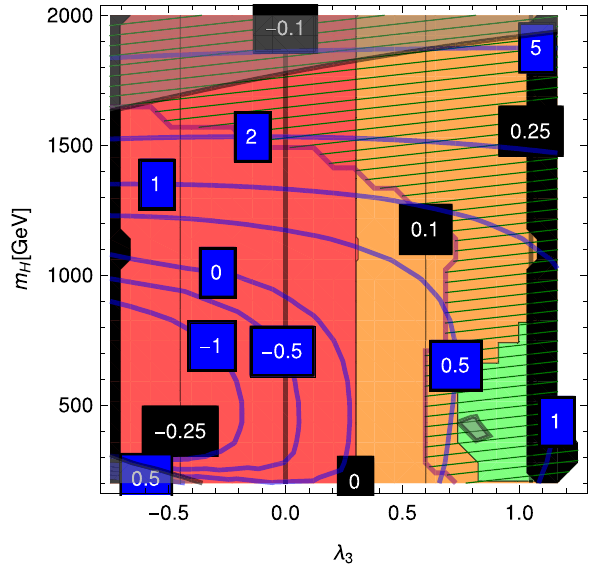
Fig. 11 Comparison of the vacuum stability at tree-level and one-loop level. The shaded areas represent the stability of the potential at tree- level: unbounded from below direction exist (red), other minima deeper than the ew vacuum exist (orange), the ew vacuum is stable (green). The green hatching indicates a stable ew vacuum at one-loop whereas no hatching corresponds to a metastable vacuum at one-loop. Black lines show the value of constant λ 3 / 3 + λ 4 at tree level, and the blue ones of min { λ 3 a + 2 λ 3 b + λ 4 a + 4 λ 4 b + 4 λ 4 c , λ 3 a + λ 4 a , λ 3 b + 2 λ 4 b , λ 3 b + √ √ λ , λ + (λ + λ )(λ + 2 λ ) + 2 λ } at one-loop. The 2 4 b 3 c 3 a 4 a 3 b 4 b 4 c black area is forbidden by the tree-level unitarity conditions. The grey shadedareaindicatestheperturbativityconstraints.Theotherparameter values are λ 2 = 0 . 1, λ 4 = − 0 . 1, λ 5 = 0 . 1, α = 15 ◦ , s H = 0 . 23